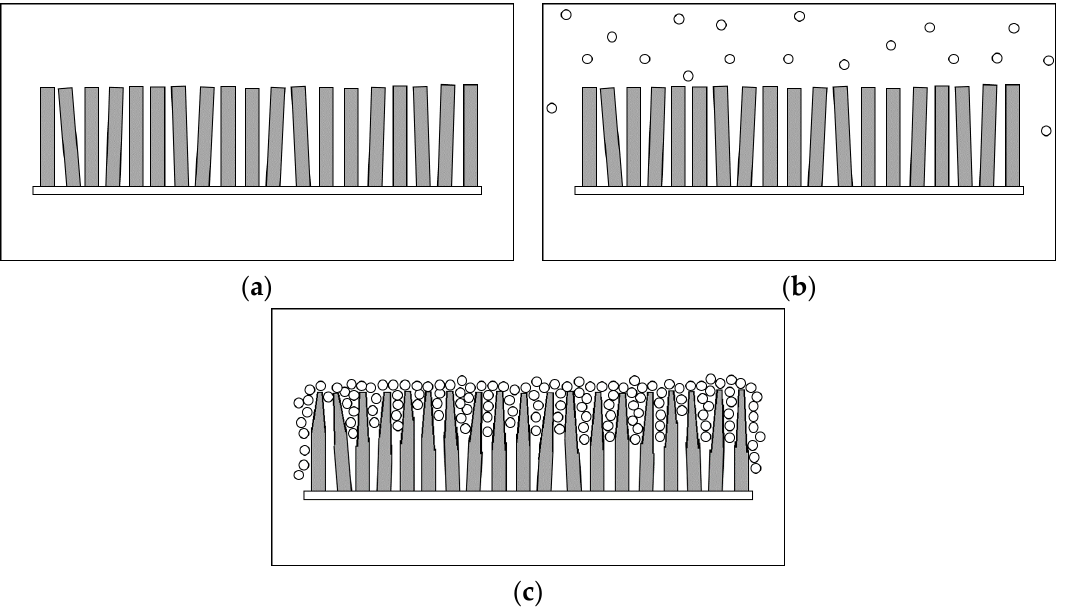
Figure 2. The schematic diagram of dip-coating method for the formation of TiO 2 loaded-ZnO: ( a ) ZnO nanorods; ( b ) dip-coating process; and ( c ) TiO 2 loaded-ZnO and followed by calcination process at 400 °C. Table 2. Average compositional ratio for ZnO, one-cycle dip-coating TiO 2 -ZnO, two-cycle